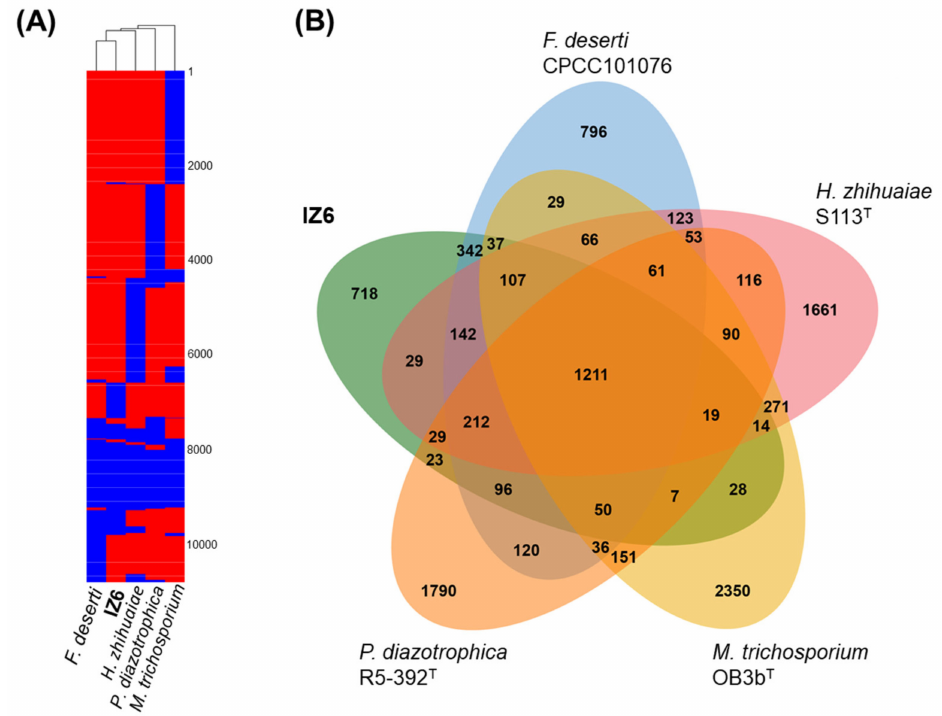
Figure 3. ( A ) Heat map and unweighted pair group method with arithmetic mean (UPGMA) dendrogram based on gene content (presence / absence) of all protein-coding sequences (CDSs) of strain IZ6 and four related strains ( Flaviflagellibacter deserti CPCC 101076, Hansschlegelia zhihuaiae S113 T , Methylosinus trichosporium OB3b T , and Pleomorphomonas diazotrophica R5-392 T ) in order Rhizobiales (class Alphaproteobacteria ). The presence and absence of genes (pan-genome orthologous groups) on the heatmap are indicated in blue and red, respectively. ( B ) Venn diagram of shared and specific CDSs among the five